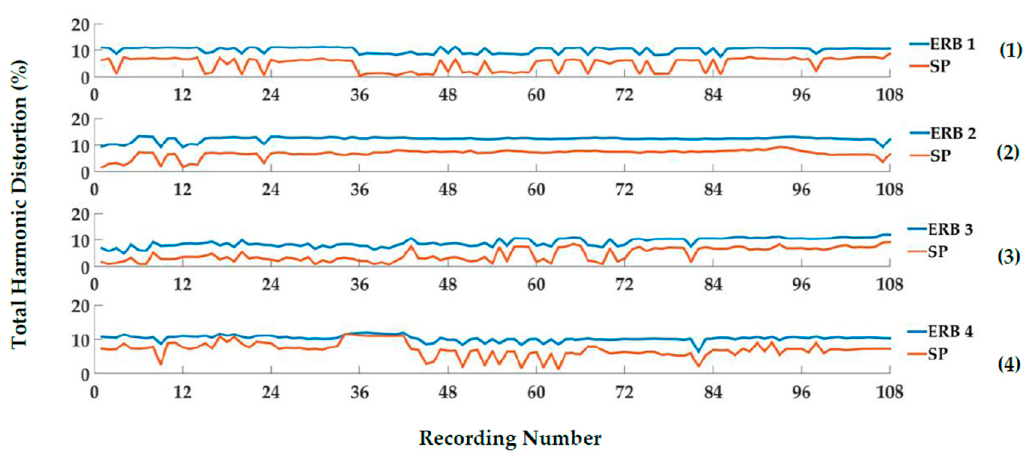
Figure 4. Total harmonic distortion of the ERBs and the SP. ( 1 ) to ( 4 ) refer to the different ERBs.